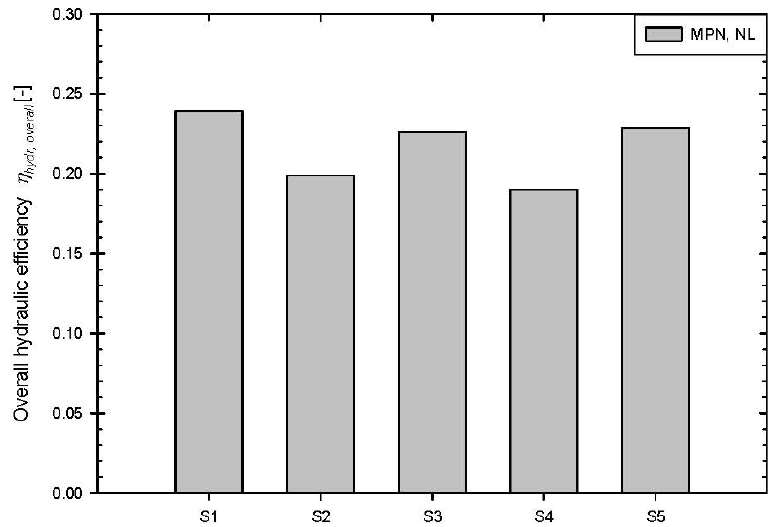
Figure A1. Comparison between effects of five scenarios on the overall hydraulic efficiency for test site at MPN, Dutch Continental Shelf.